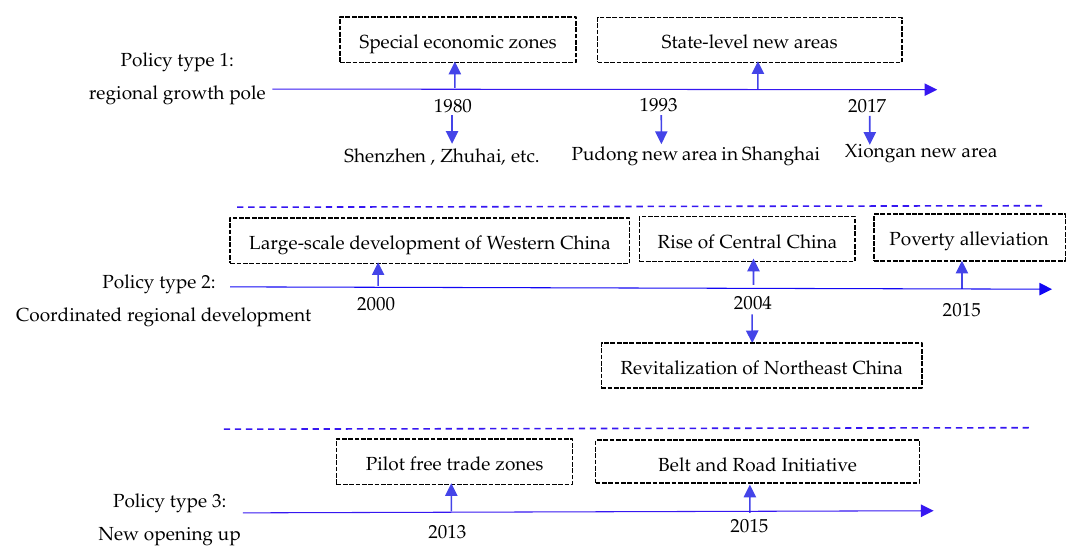
Fig. 6 Current policies of China: regional growth pole,coordinated regional development and new opening